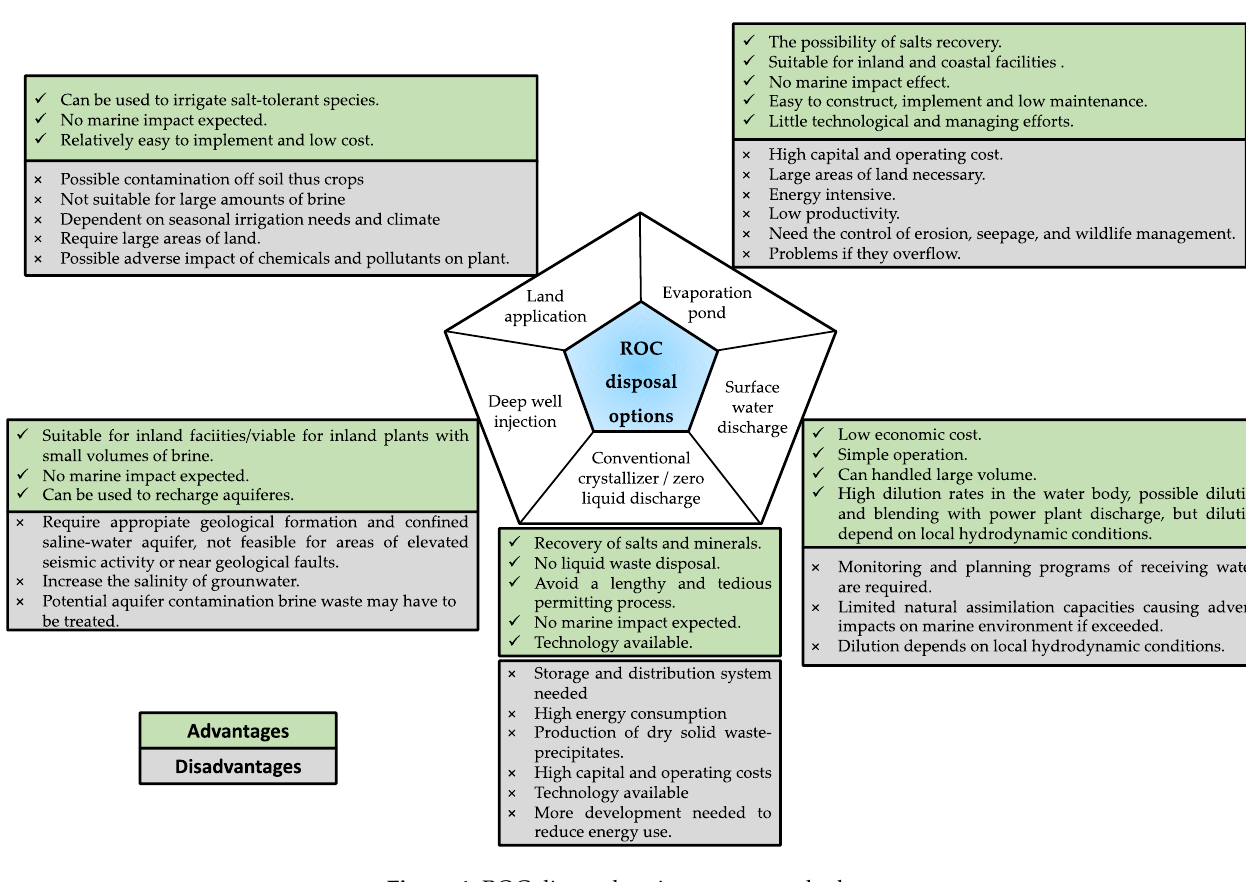
Figure 4. ROC disposal options conceptual scheme